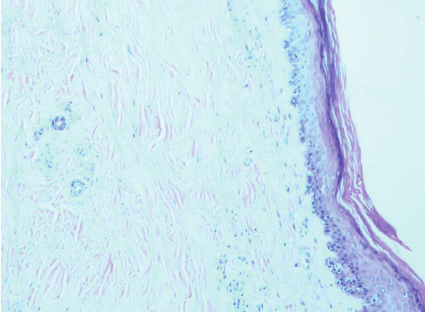
Figure 4: Skin biopsy: colloidal iron with hyaluronidase × 100. Dermal mucin deposition without fibroblast proliferation, with interface vacuolar changes.